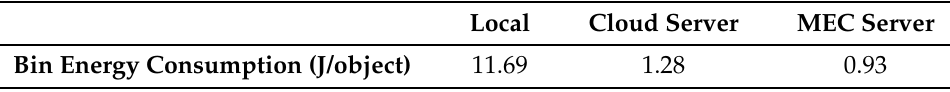
Figure 12. Energy measurement during one normal operation cycle. Table 8. Energy consumption of the Raspberry Pi when the waste classifier is run locally, on the MEC or on the cloud